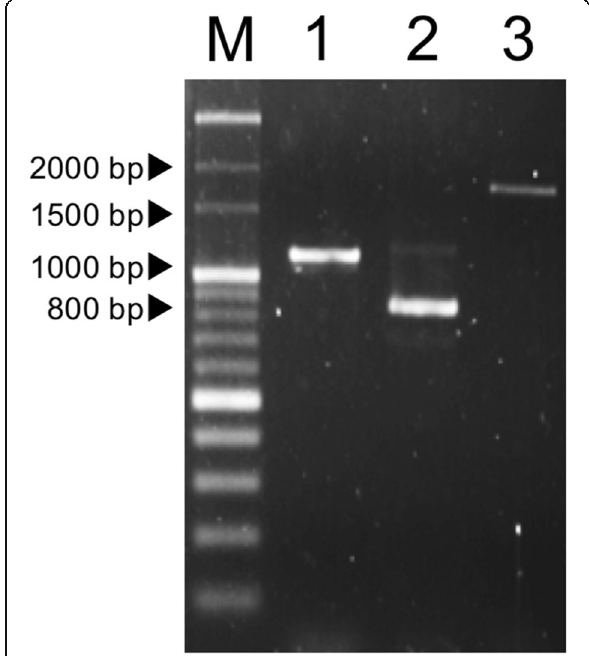
Fig. 1 Dog CMAH cDNA amplified from total RNA extracted from bone marrow by RT-PCR. M: 100bp DNA Marker (Bio Regenerations Co. Ltd.), Lane 1: cDNA encompassing exons 1a to 9 (Fragment 1 in Table 3), Lane 2: cDNA encompassing exons 8 to E15 (Fragment 2 in Table 3), 3: Lane cDNA encompassing exons 1a to E15 (Fragment 3 in Table